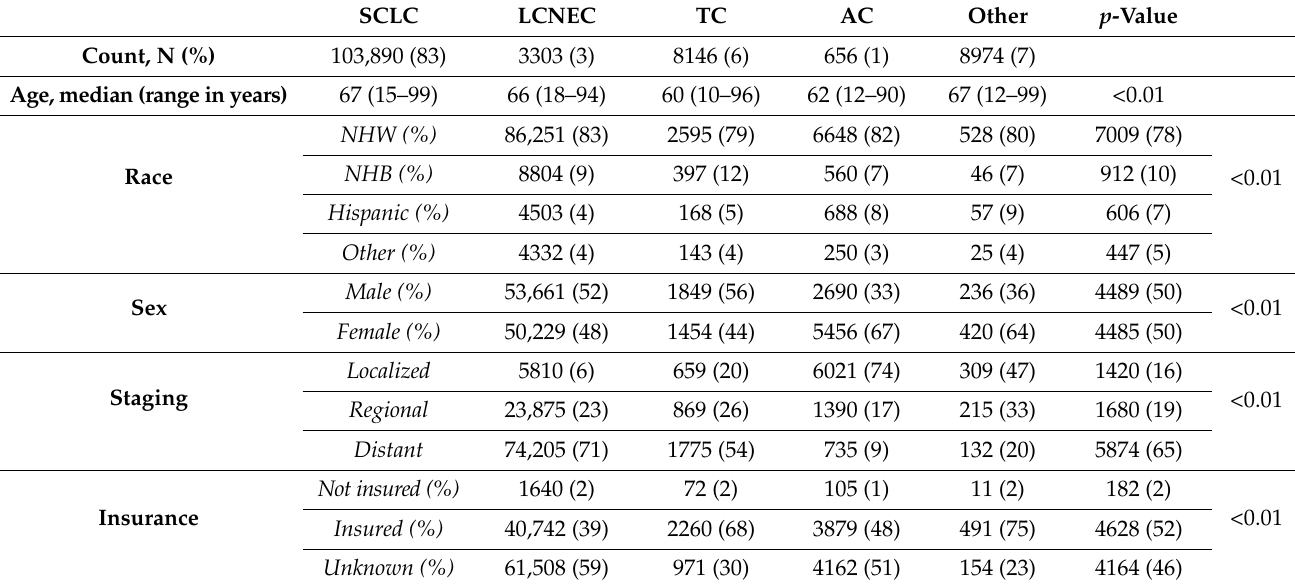
Table 1. Demographic and clinical characteristics of patients with lung NENs.